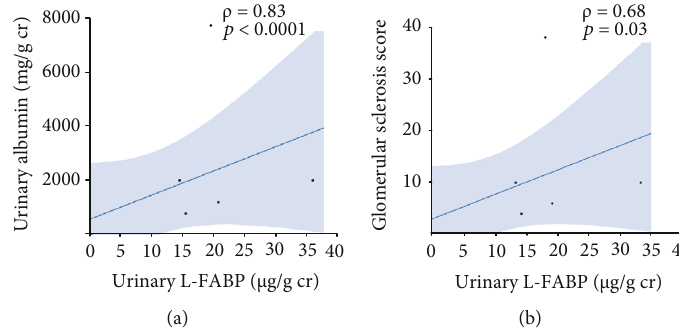
Figure 9: Correlations of urinary L-FABP with urinary albumin (a) and glomerular sclerosis